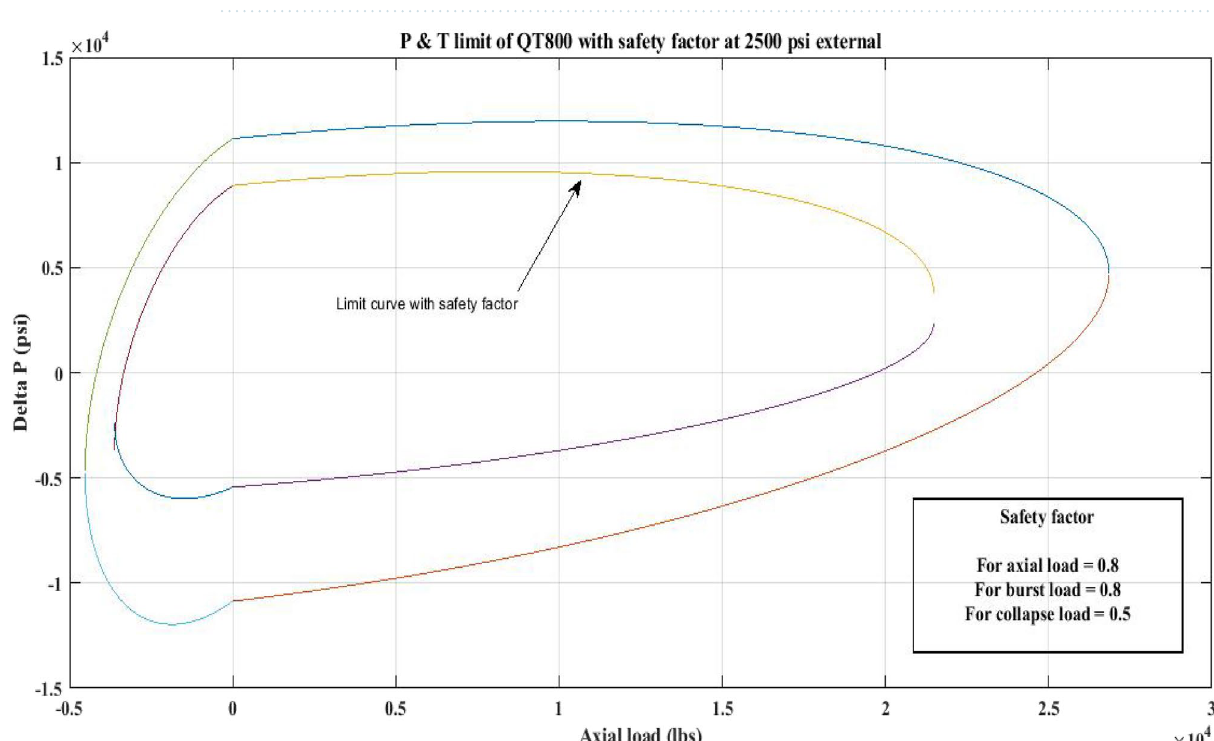
Figure 17. P and T limit with safety factor for QT 800 at 2500 psi P o